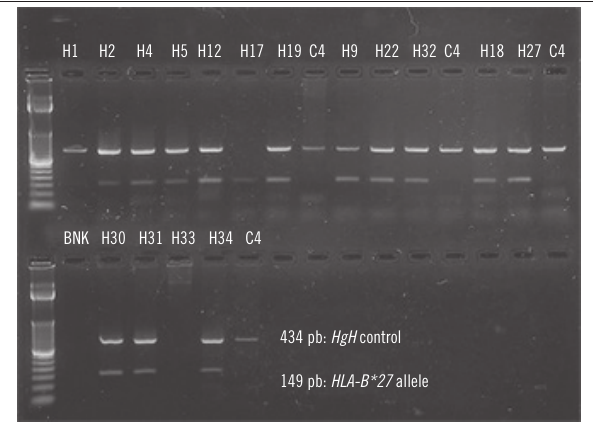
FigurE − Band pattern of positive and negative samples for HLA-B*27 by PCR-SSP in agarose gel with standardized mix PCR-SSP: polymerase chain reaction-single specific primer; HLA: human leukocyte antigens; H: HLA-B*27 positive; C: HLA-B*27 negative; BNK: blank. Step ladder: 50